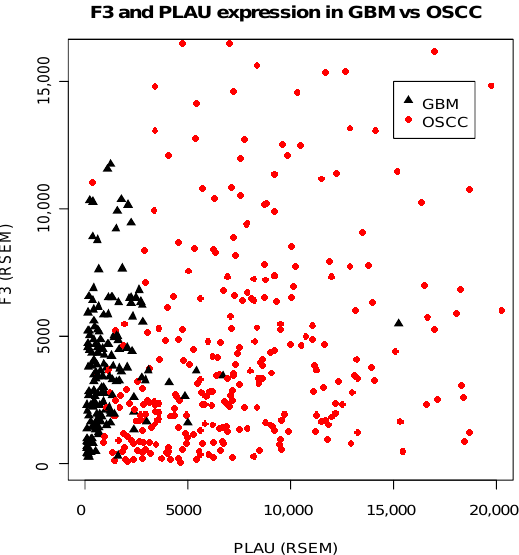
Figure 2. Inter-tumor heterogeneity of F3 and PLAU expression in OSCC and GBM. Comparison of F3 and PLAU expression in OSCC (red, n = 321) and GBM (black, n = 166) from TCGA. mRNA levels are shown as RSEM, showing the great inter-tumor heterogeneity of OSCC tumors. Note that each dot represents an individual